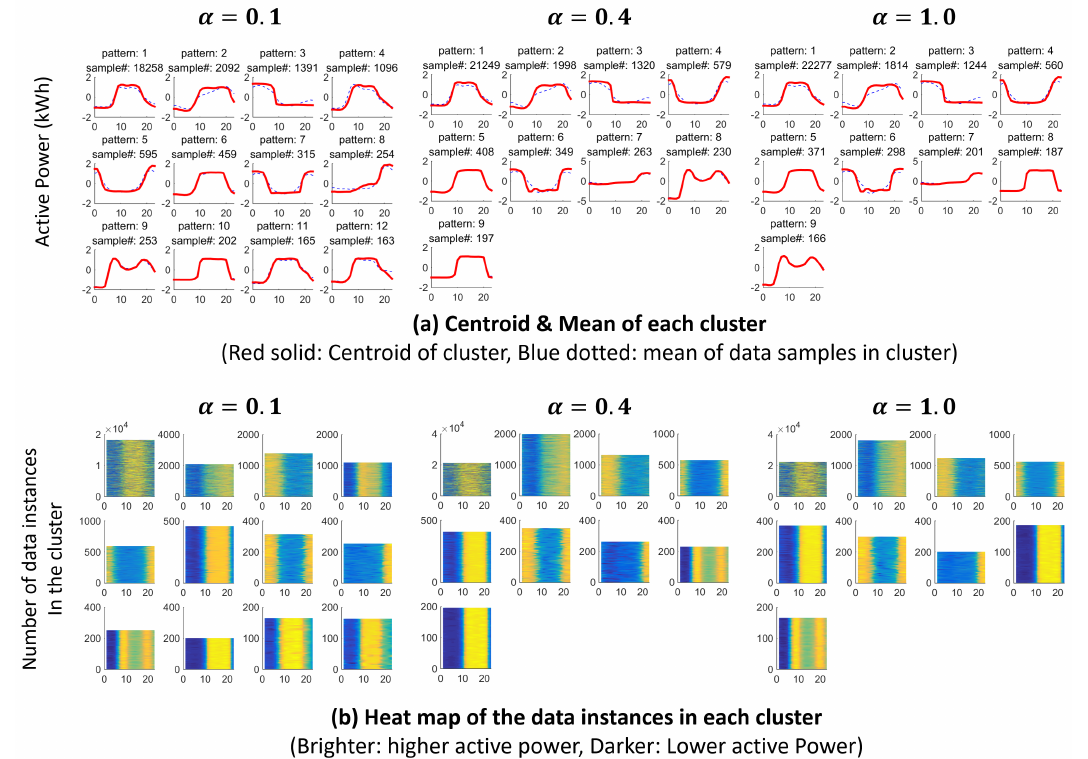
Figure 9. Clustering results of KEPCO data set with SPCC distance.